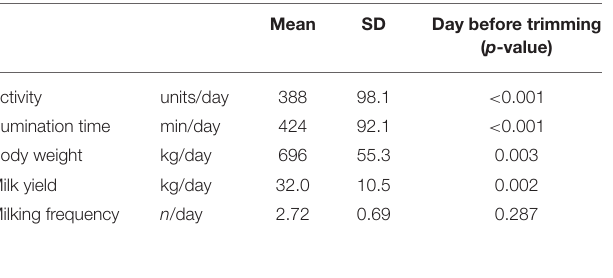
TABLE 1 | Daily activity, rumination time, body weight, and milk yield of 22 multiparous Italian Holstein cows during the 15-day period preceding a first hoof trimming session in which they were diagnosed without claw disorders.